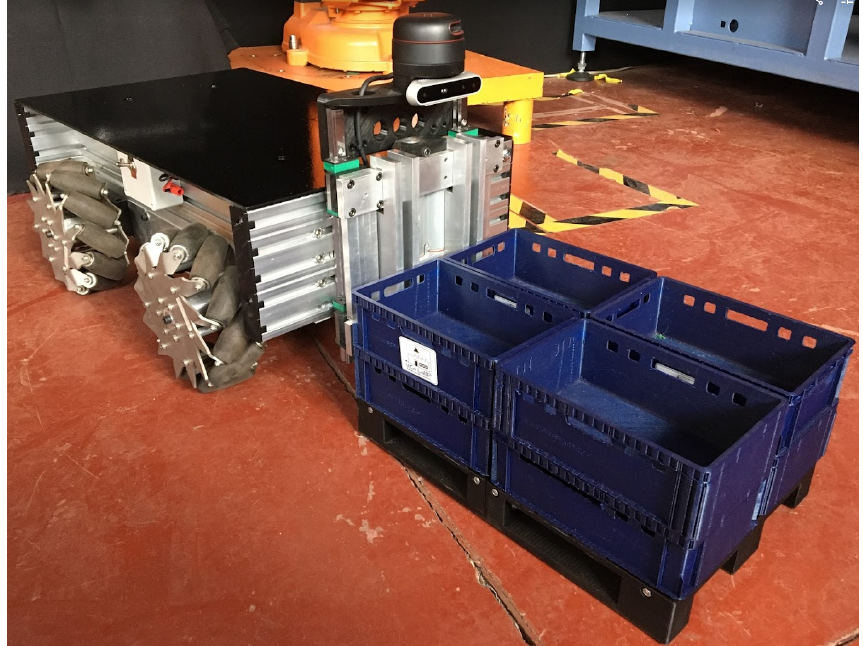
Figure 2. The forklift-type mobile robot with Mecanum wheel carrying EURO pallet with eight